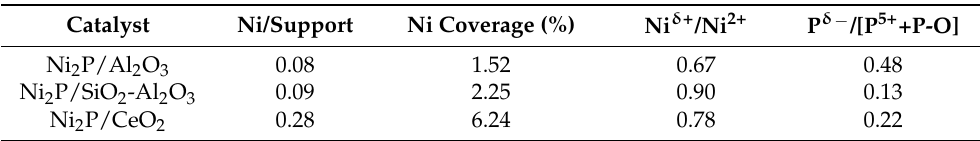
Table 2. Surface composition of the catalysts as determined by XPS analysis, the atomic ratios of nickel to support material.